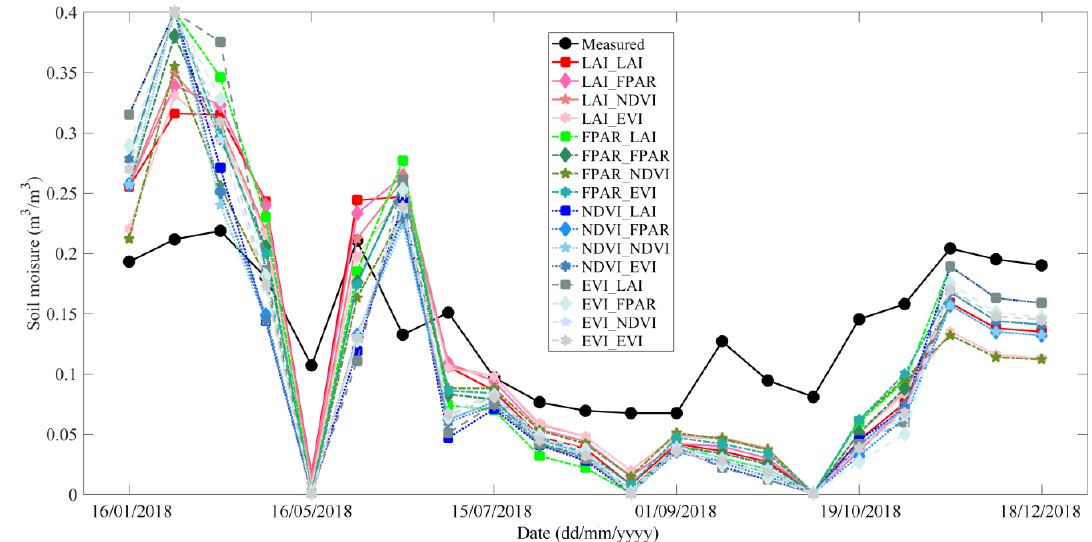
Figure 7. Soil moisture estimated from the coupled model with the different vegetation combinations. The boxplots show the median (red horizontal line), mean (black cycle), 25th and 75th percentiles (top and bottom of the blank box, respectively), and the outlier ranges (edges of the top and bottom whiskers). The “LAI_FPAR” indicates that the V 1 and V 2 are characterized by the LAI and FPAR, respectively.